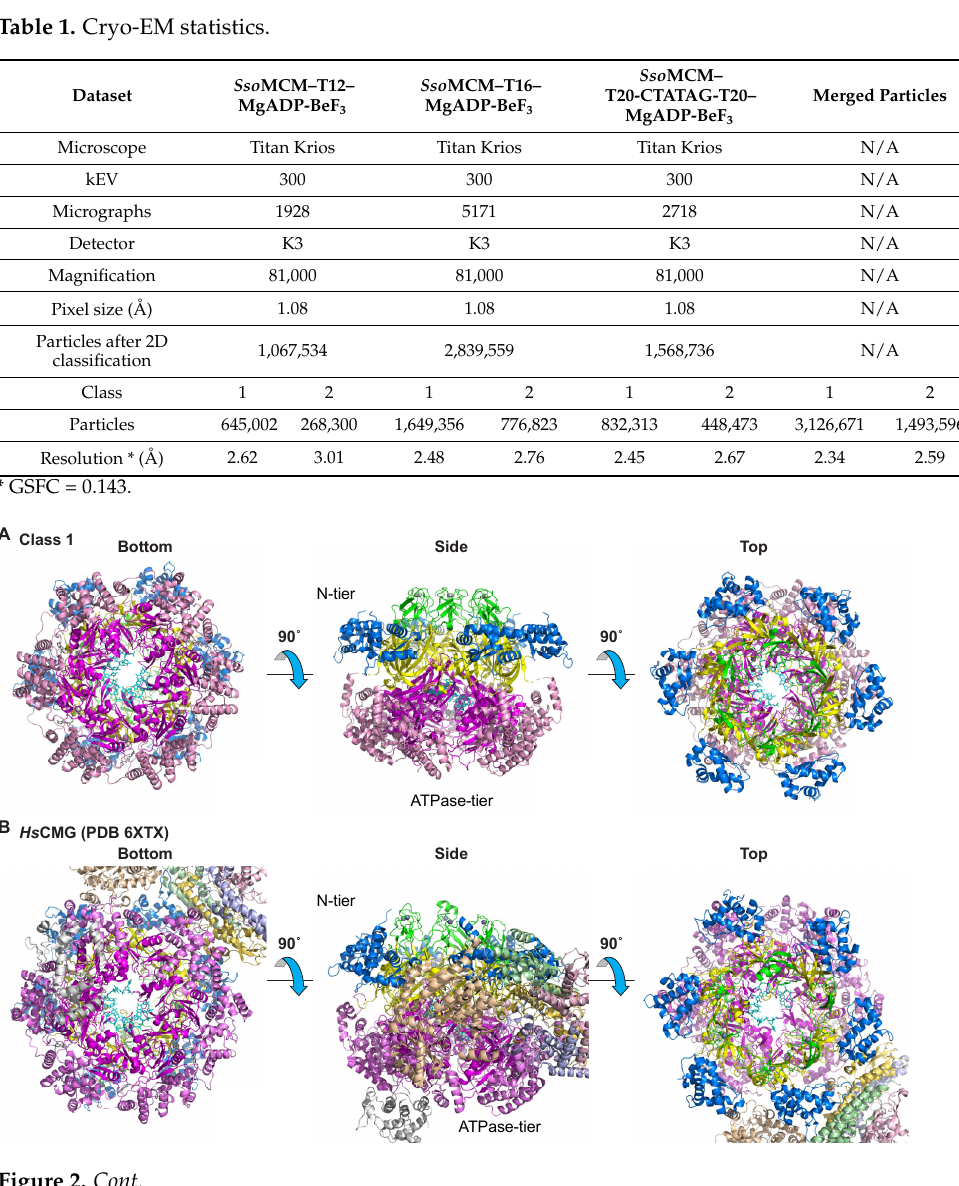
Table 1. Cryo-EM statistics.